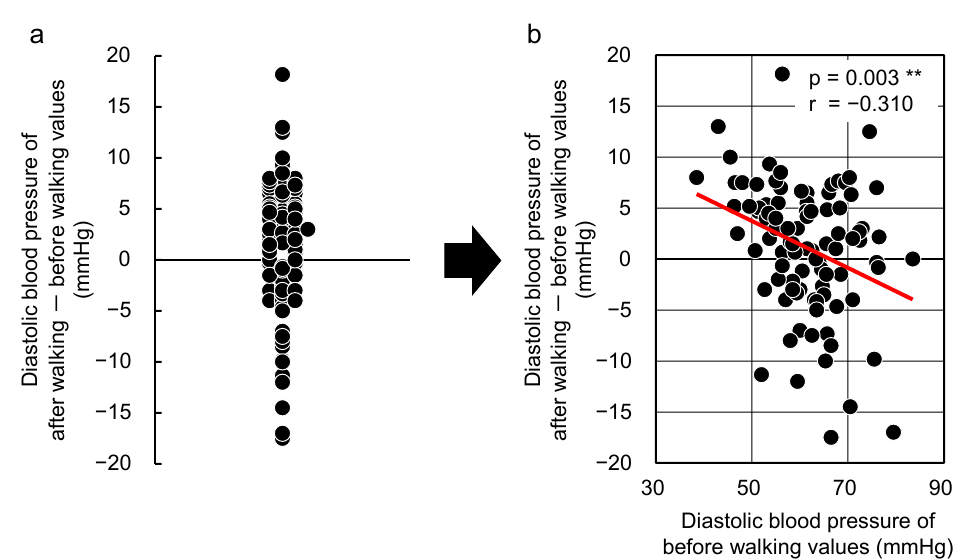
Figure 2. Changes observed with respect to walking in a forested area. Individual differences ( a ) and the relationship between the “initial value” and the “changes after walking in a forested area” ( b ) with respect to diastolic blood pressure ( n = 92). ** p < 0.01 by Pearson correlation test [70].